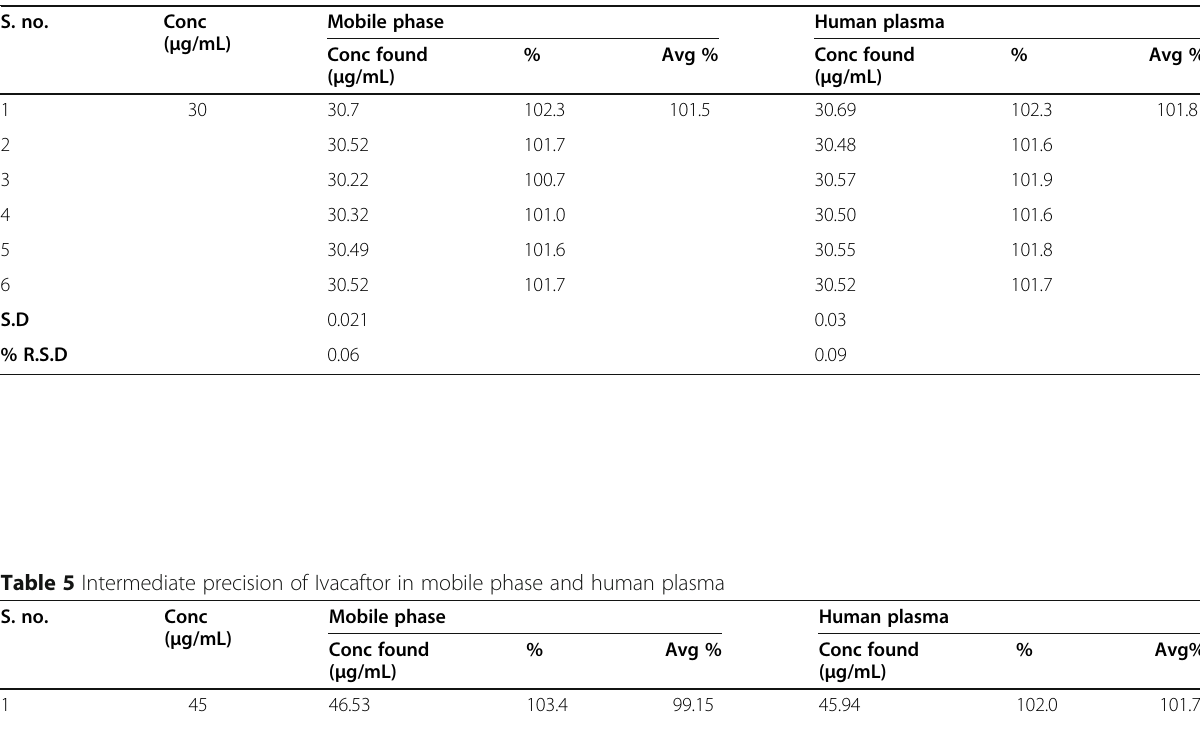
Table 4 Intermediate precision of Tezacaftor in mobile phase and human plasma S. no.